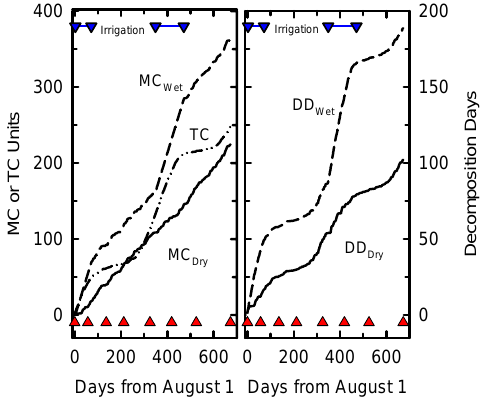
Figure 1. Cummulative daily Temperature Coefficients (TC), daily Moisture Coefficients (MC), Decomposition Days (DD) for dry and wet treatments as functions of calendar days from start of the experiment on August 1, 2006. The inverted blue triangles joined a blue line indicate days when irrigation was applied. Solid red triangles indicate sampling dates.